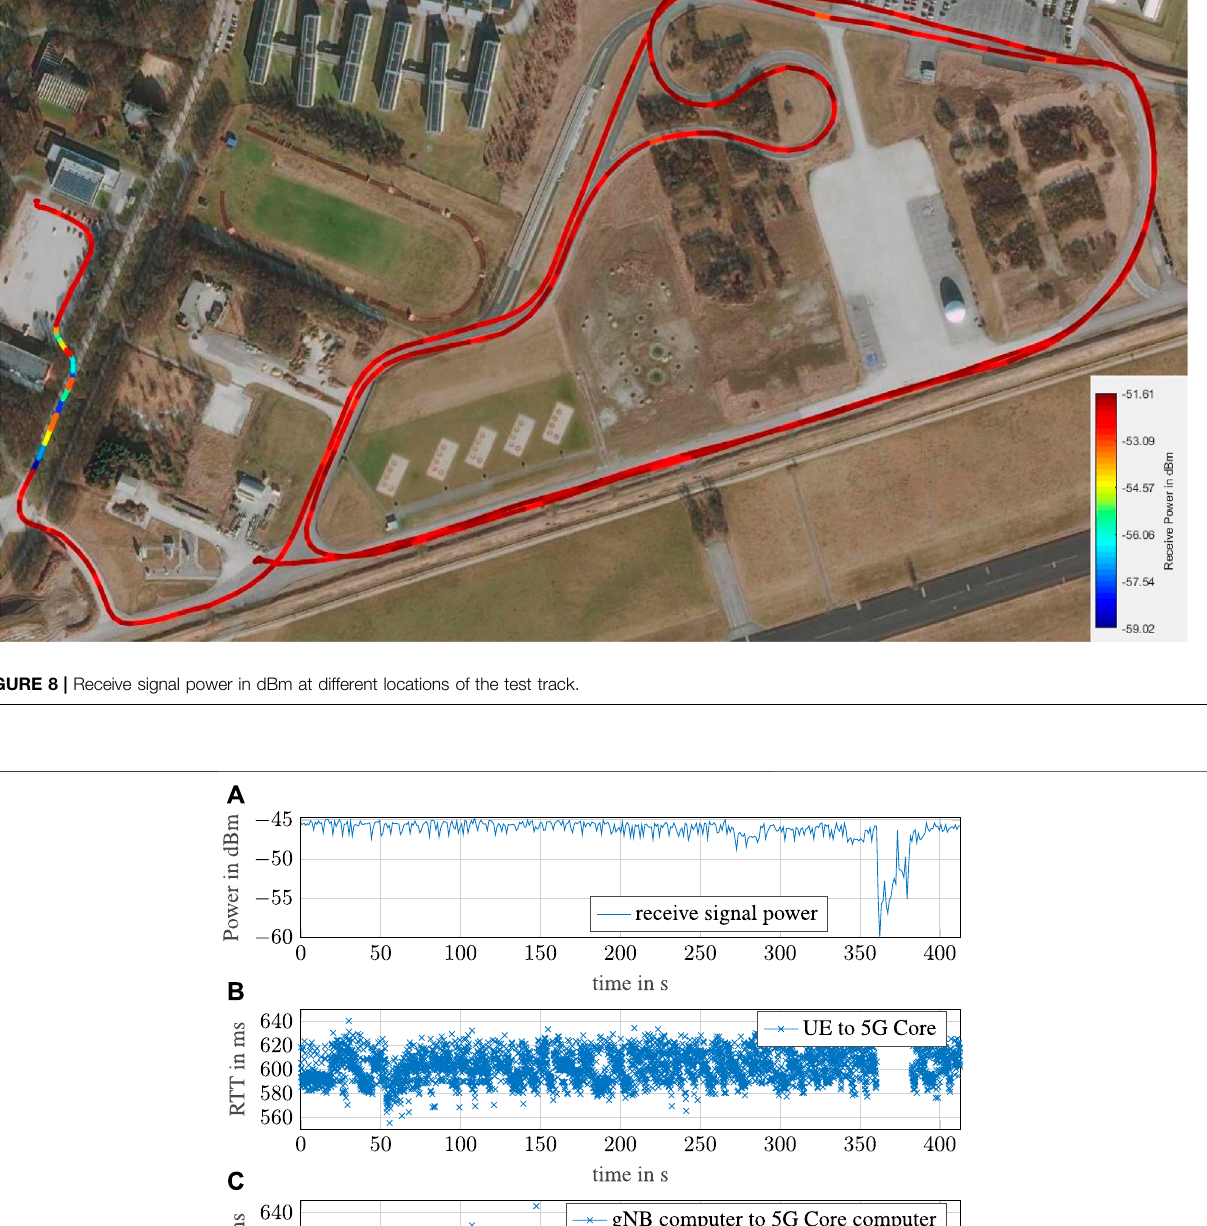
Frontiers in Communications and Networks |